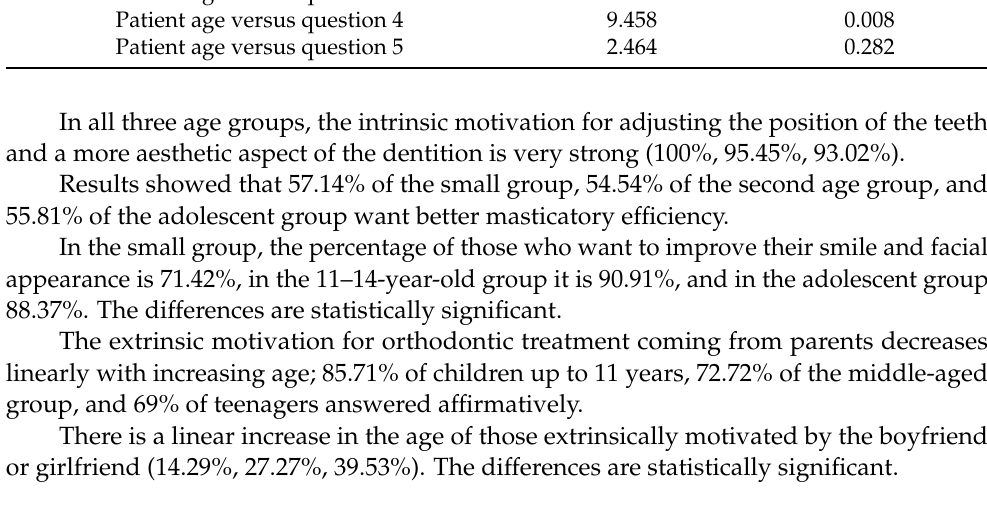
Table 6. The results of Questionnaire II according to the age of the subjects. Chi 2 p -Value Patient age versus question 1.1 3.087 0.202 Patient age versus question 1.2 0.049 0.961 Patient age versus question 1.3 7.978 0.017 Patient age versus question 2 3.970 0.132 Patient age versus question 3 8.767 0.011 9.458 0.008 2.464